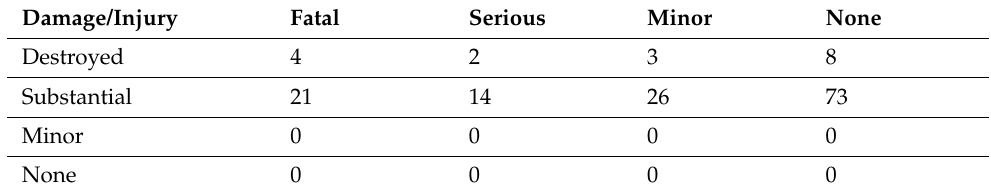
Table 2. Injury severity compared with damage to the helicopter (# accidents).